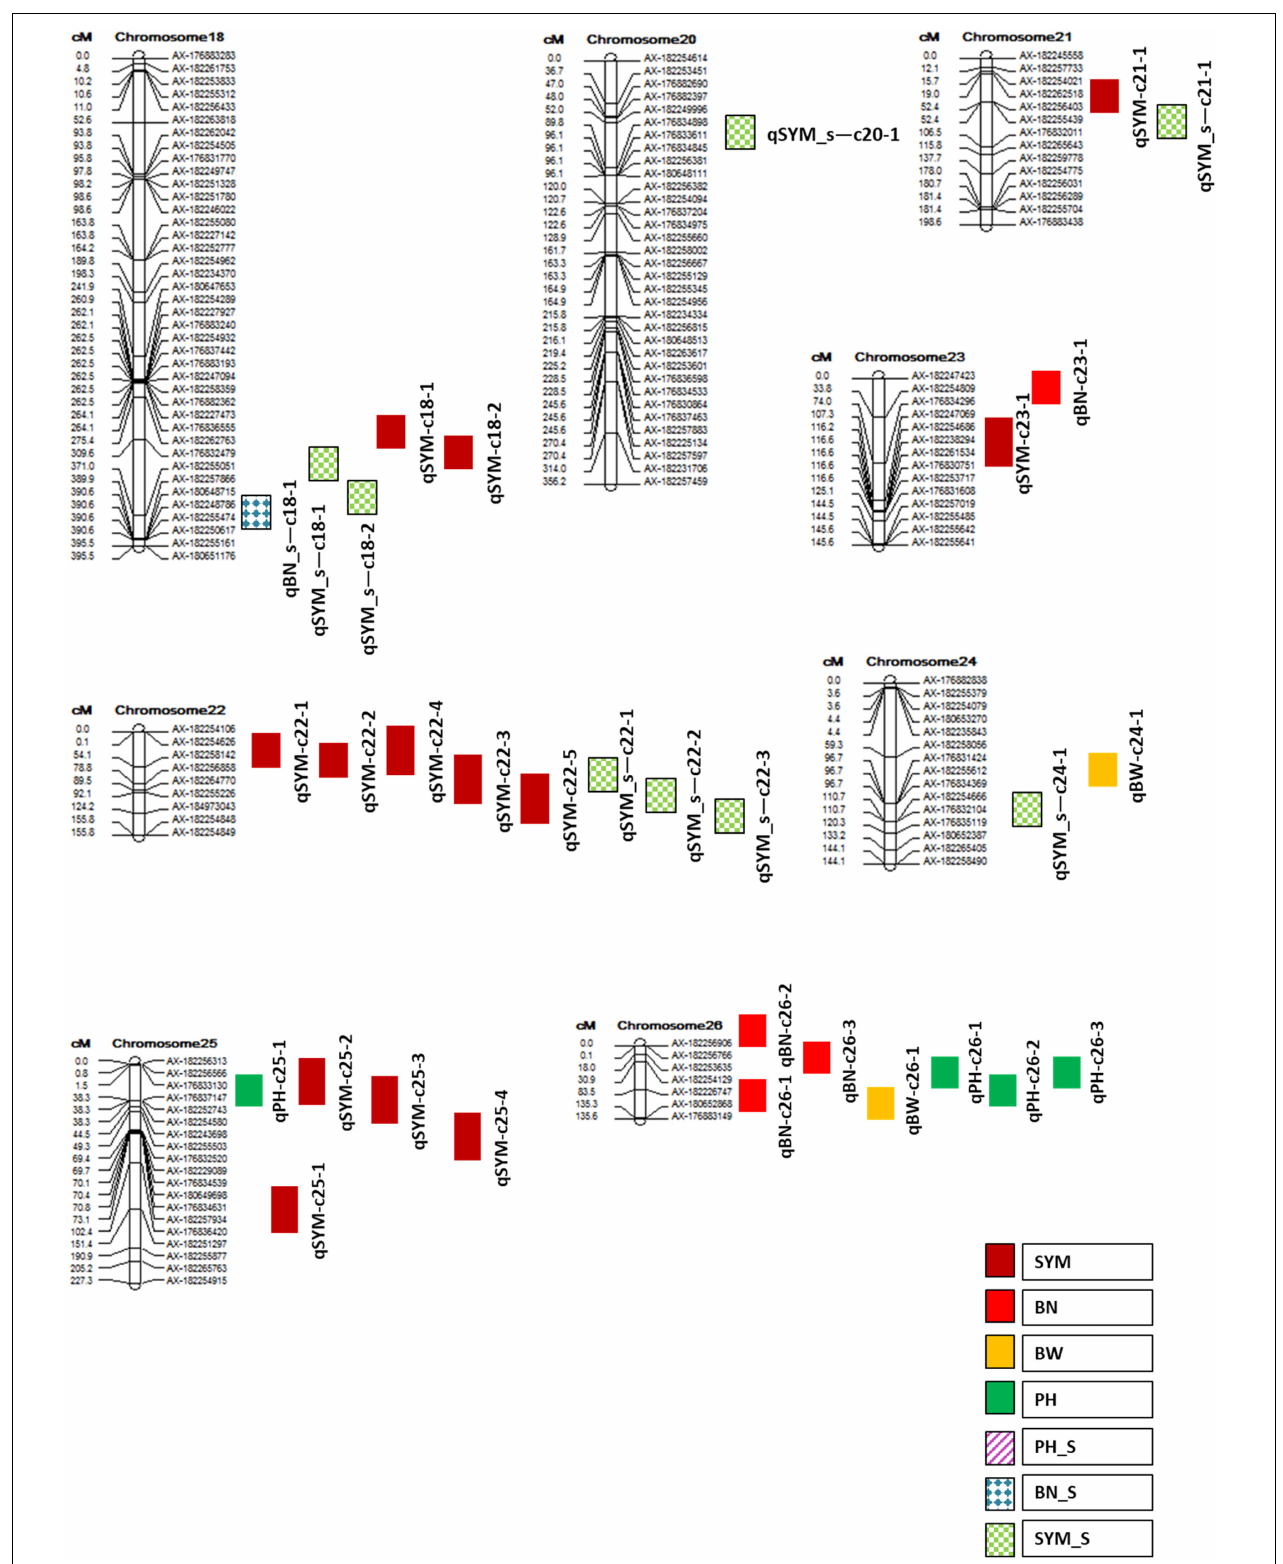
FIGURE 1 | Linkage map showing the relative positions of quantitative trait loci (QTL) identified in this study. QTL nomenclature is as indicated in Table 6 .